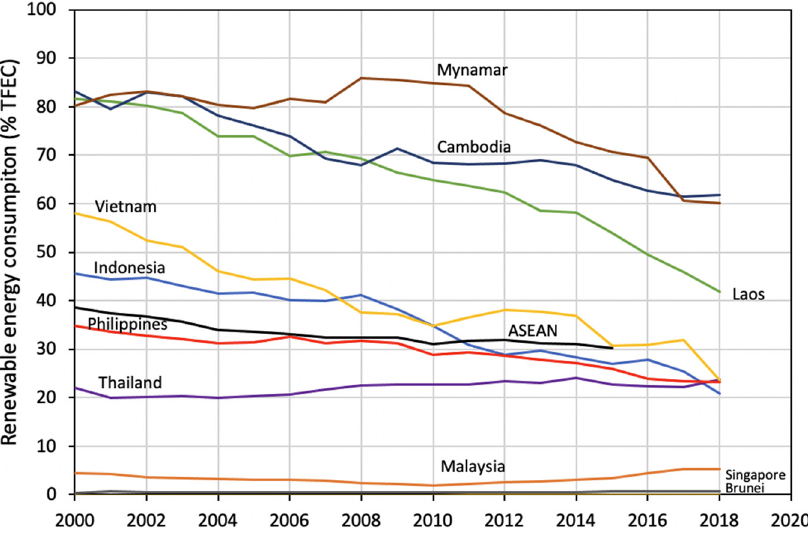
Figure 19. History of renewable energy consumption as percent of TFEC in ASEAN [44] .